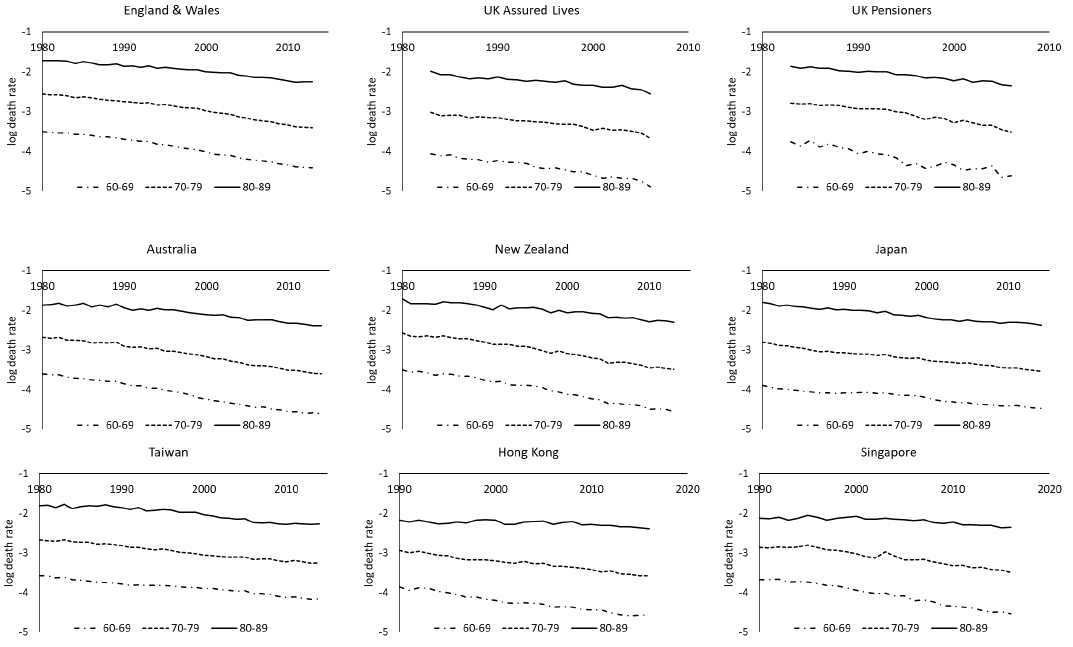
Figure 3. Log central death rates of male lives in UK and Asia–Pacific regions, 1980–2016.